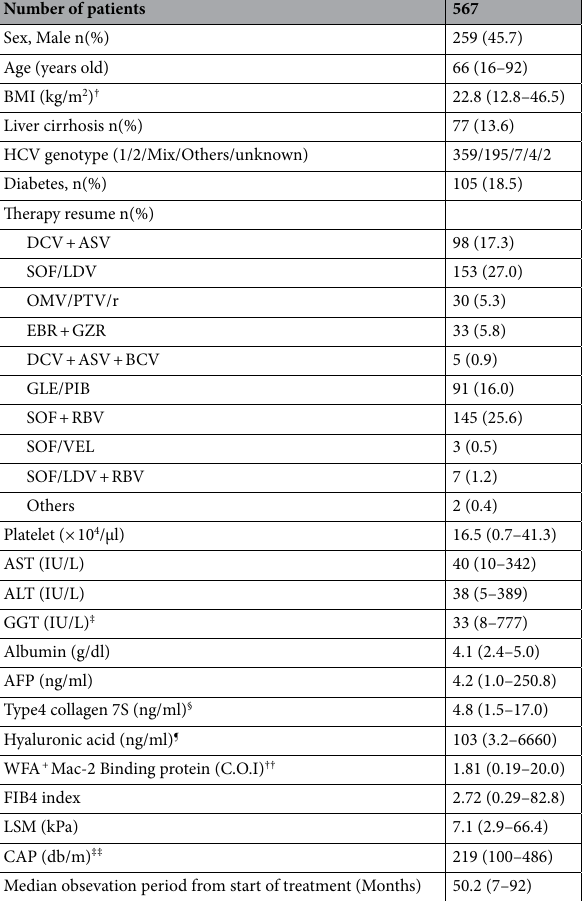
Table 1. Baseline characteristics of patients. † The data include only 441 patients, ‡ The data include only 355 patients. § The data include only 233 patients, ¶ The data include only 327 patients. †† The data include only 431 patients, ‡‡ The data include only 332 patients. BMI Body mass index, HCV Hepatitis C virus, DCV daclatasvir, ASV asnerprevier, SOF/LDV sofosbuvir/ledipasvir, OMV/PTV/r ombitasvir/paritaprevir/ ritonavir, EBR Elbasvir, GZR Grazoprevir, BCV Beclabuvir, GLE/PIB Glecaprevir/Pibrentasvir, RBV Ribavirin, SOF/VEL sofosbuvir/velpatasvir, AST Aspartate transaminase, ALT Alanine aminotransferase, GGT γ-glutamyltransferase, AFP α-fetoprotein, WFA Wisteria floribunda agglutinin, LSM Liver stiffness measurement, CAP Controlled attenuation